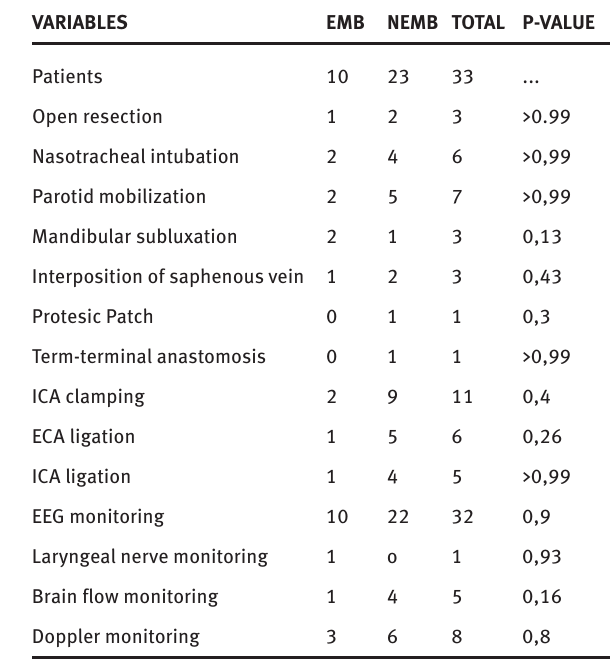
Table 1: Demographic and glomic tumor variables in PE group (Preoperative Embolisation) and N-PE group (Non-Preoperative Embolisation: isolated traditional surgery) VARIABLES